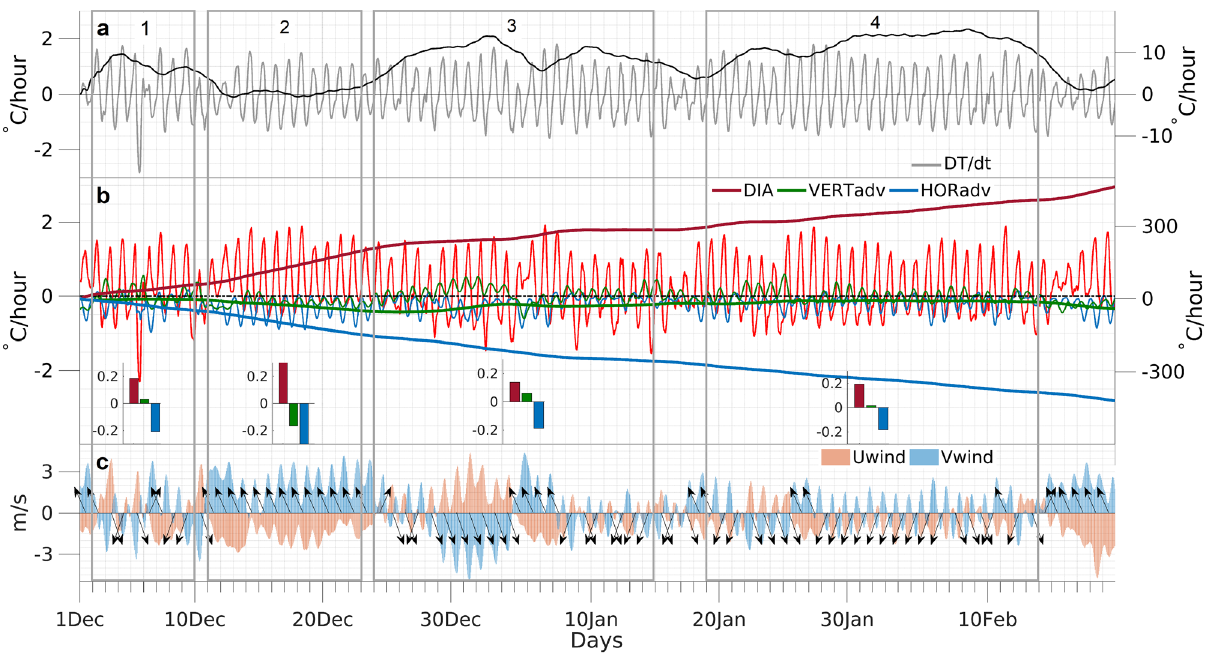
Figure 6. Atmospheric mesoscale characterization of the 2013/2014 summer over the UASP. Time series of area average values computed (at an hourly scale) for the UASP and throughout the 2013/2014 summer season of several regional high resolution meteorological parameters. 925-hPa (local near-surface) temperature variation rate (grey line) and respective cumulative values (accumulated over time, black line) ( a ). Contribution of the diabatic term (red), of vertical (green) and horizontal (blue) temperature advection terms for the observed 925-hpa temperature variation rate (see “Data and methods” section) ( b ). Ticker lines indicate the cumulative values. The inset bar plots show the mean hourly contribution of each mechanism during each one of the four previously defined periods within the summer season. Time series of zonal (Uwind) and meridional (Vwind) wind components (colors) ( c ). Arrows indicate the daily predominant wind direction. The location of the model grid-points considered for the computation of these area averaged time series for the UASP is shown in Fig.